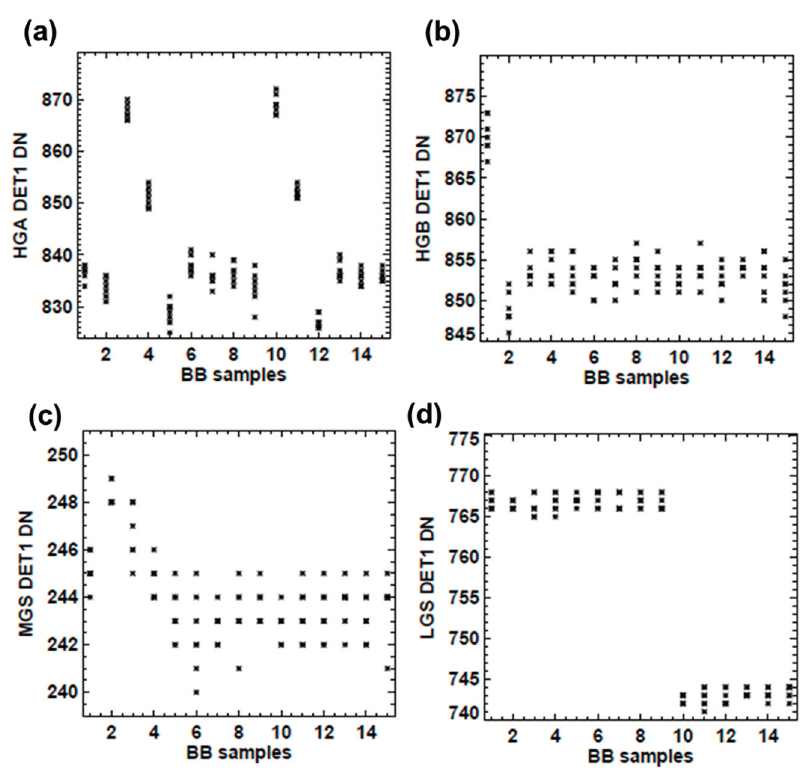
Figure 8. Repeat DNB measurement of DN at each BB sample during orbit 6600 (4 February 2013, 13:23 UTC) when the spacecraft is on the dark side of the Earth. HGA, HGB, MGS and LGS are shown from ( a ) to ( d ). The repeated dark measurements show a fixed pattern behavior that is different across gain stages. The plots show aggregation Mode 26, Detector 1 as an example, and the fixed pattern is different at different aggregation modes and